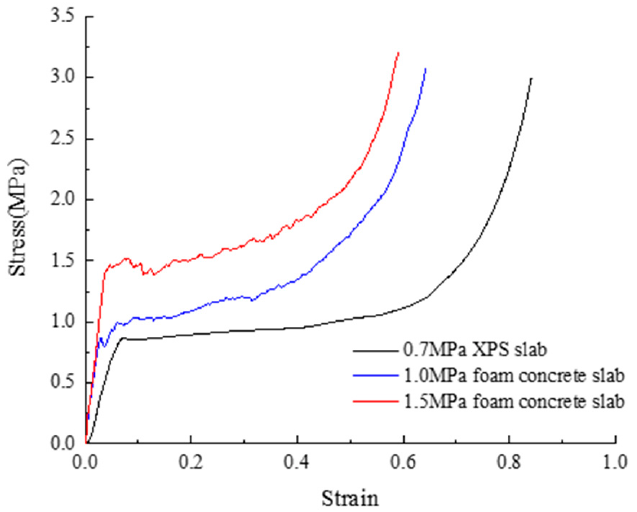
Figure 2. Typical stress–strain curve of XPS slab and foam concrete slab.